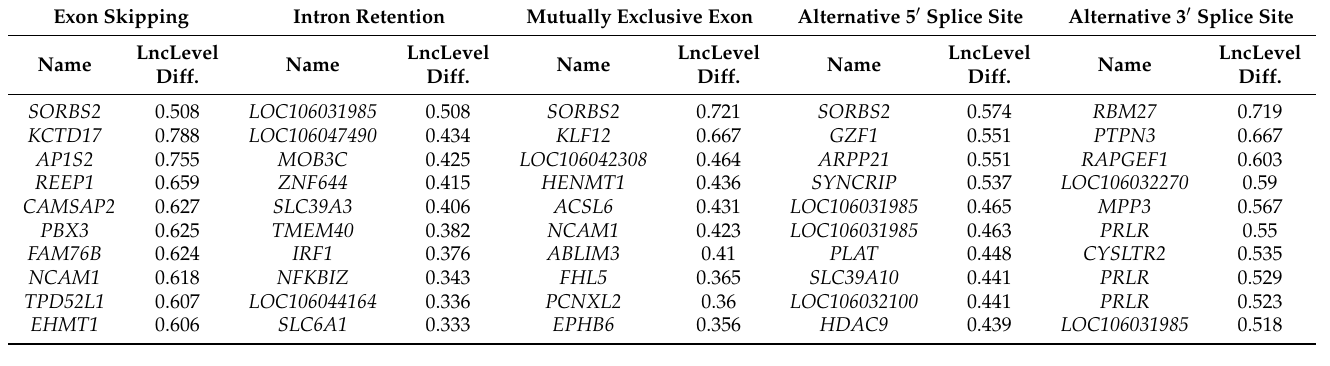
Table 3. The top ten DSGs.